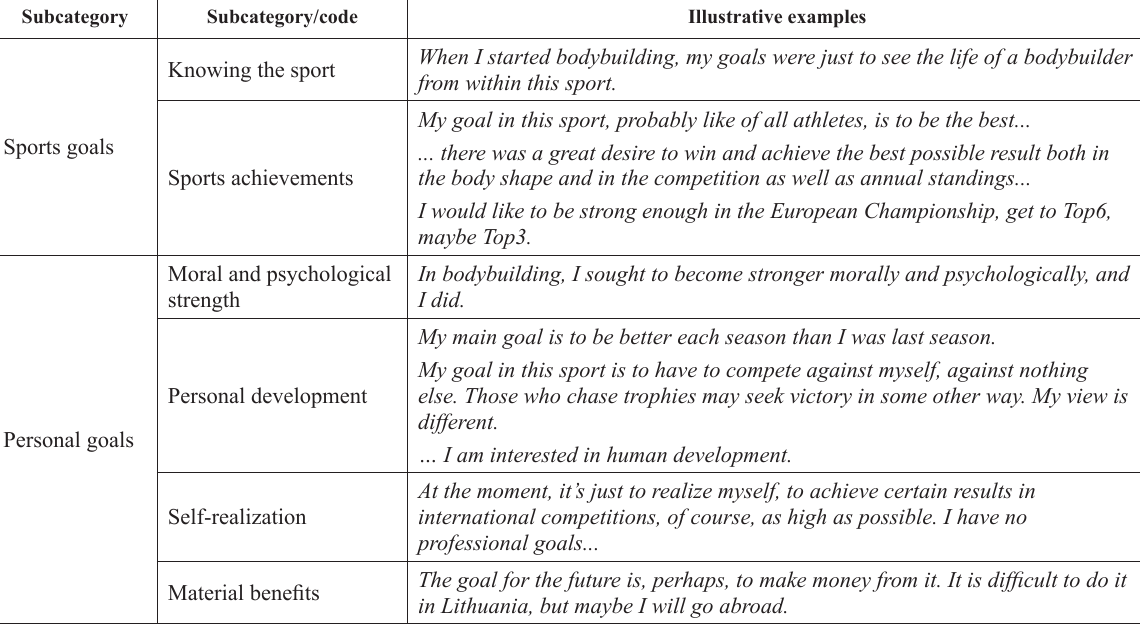
Table 1. Category: Athletes’ goals in bodybuilding